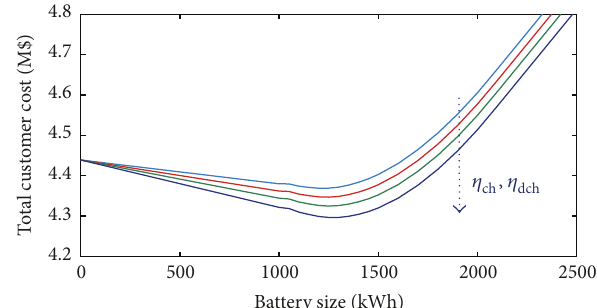
Figure 7: Total customer cost with 𝛼 = 5 %, 𝛽 = 5 %, 𝜂 = 98 % for different values of annual load variation (industrial 𝜂 dch load).